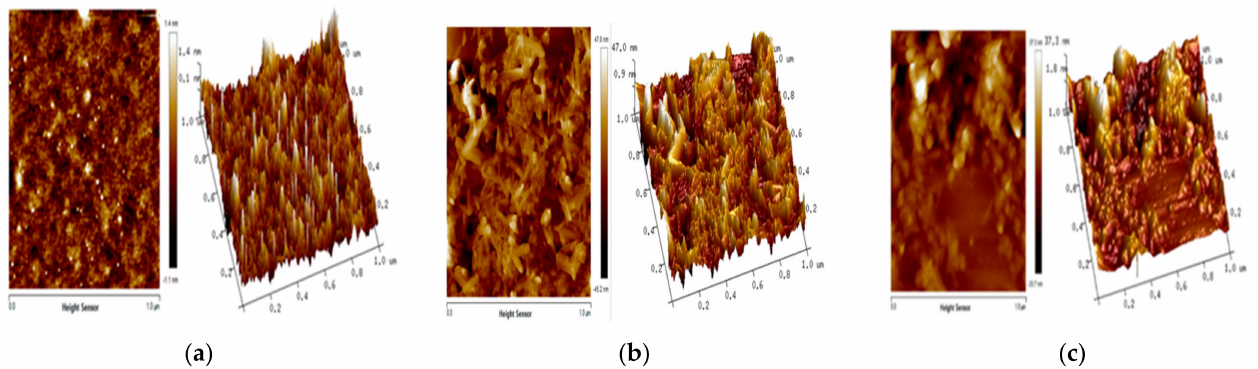
Figure 5. Atomic force microscopy image of ( a ) chitosan thin film, ( b ) Fe 2 O 3 thin film, ( c ) and a composite chitosan/Fe 2 O 3 thin film